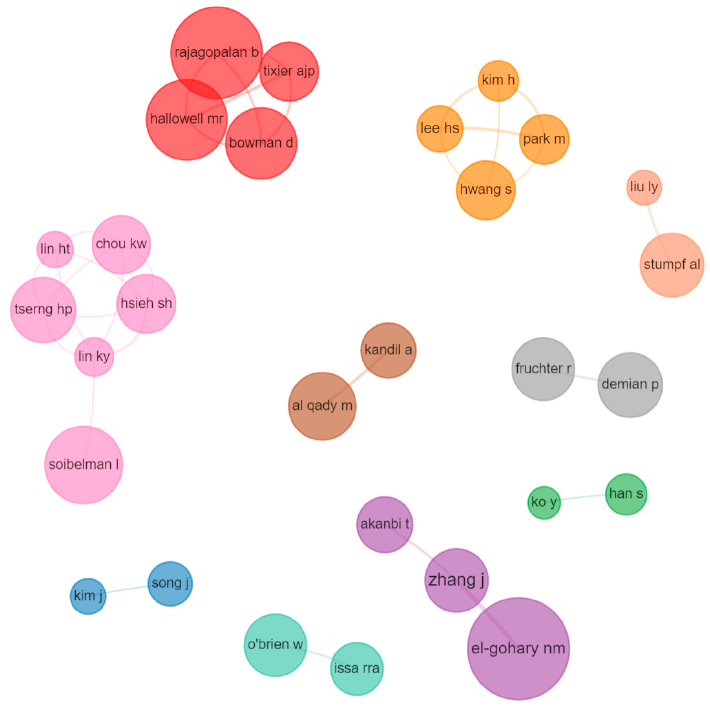
Figure 18. Co-authorship network. Software: BiblioShiny version 3.0.